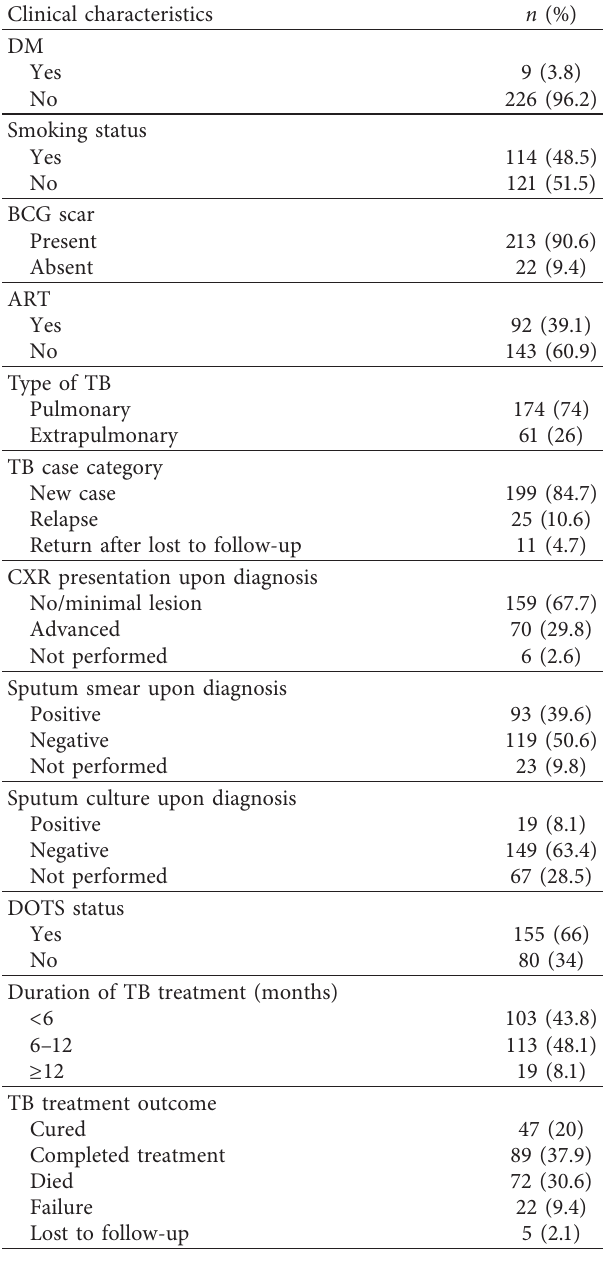
Table 2: Clinical characteristics of patients with TB-HIV coin- fection (total patients, n � 235). Clinical